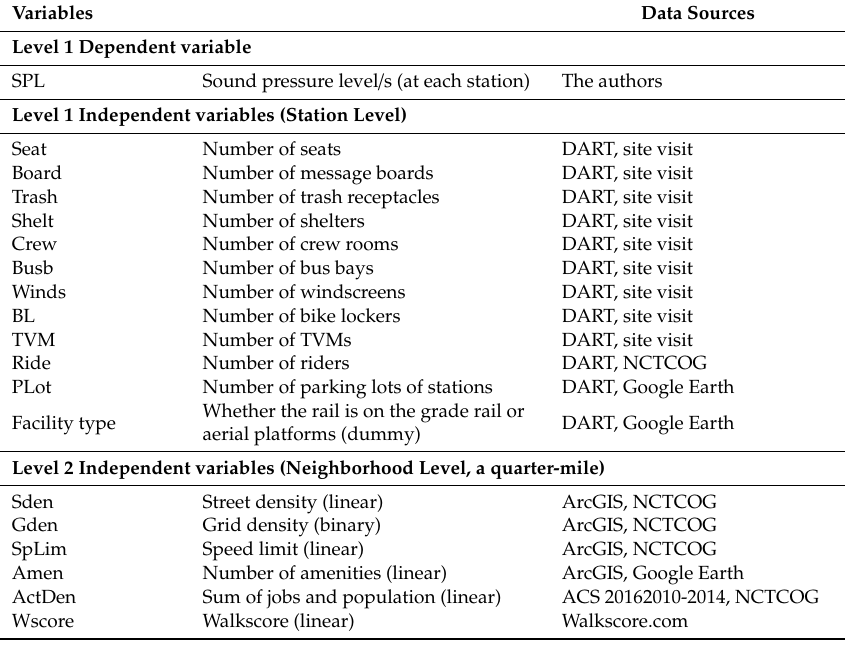
Table 3. Variables used to explain the odds of sound pressure level (SPL) in the transit-oriented developments (TODs).